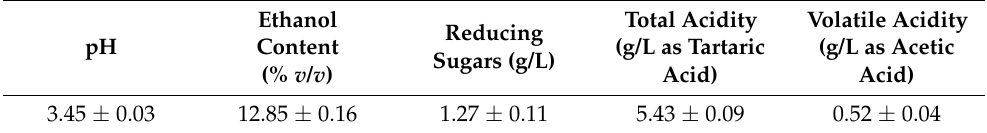
Table 2. Analytical data of base Syrah red wine (Means ± SD, n =